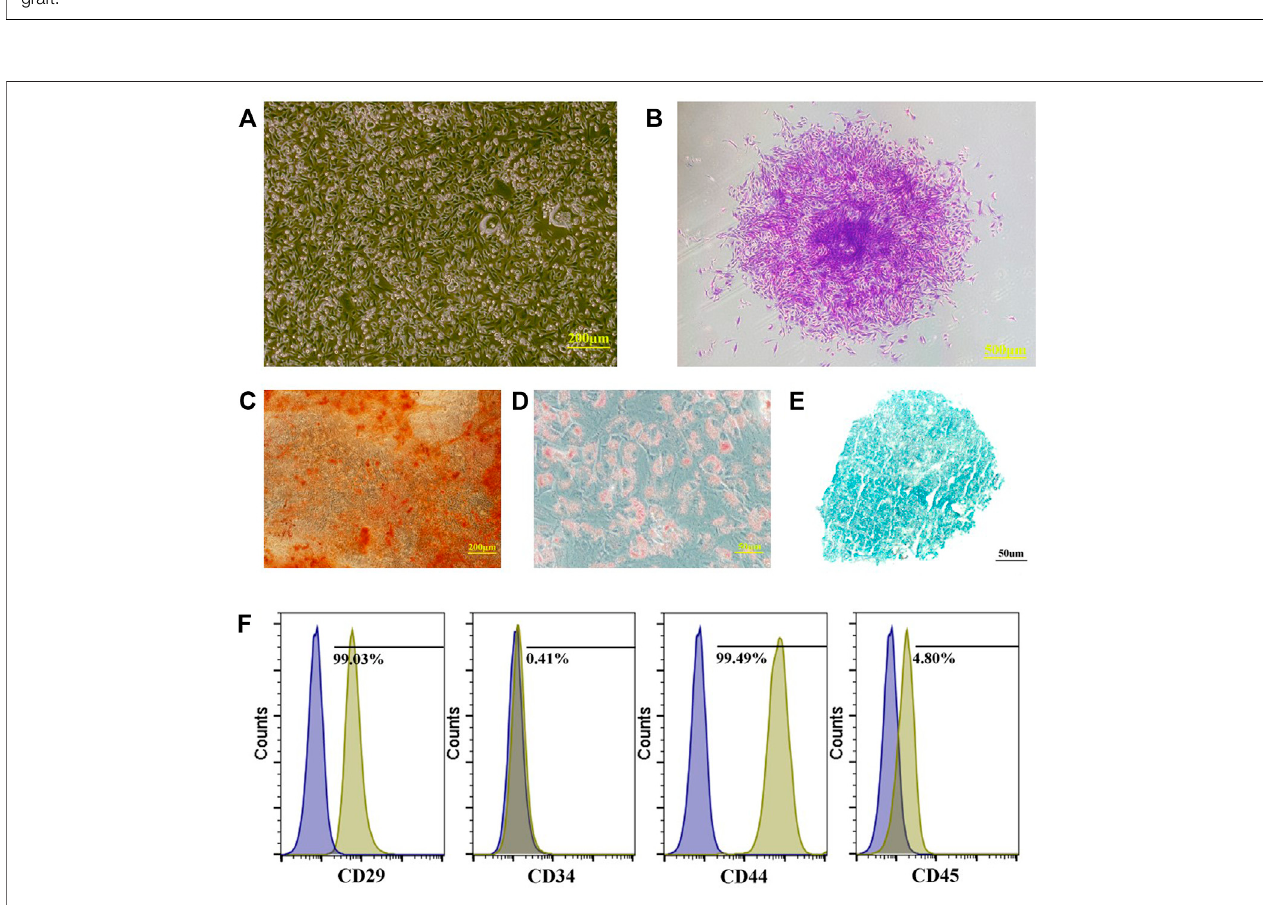
FIGURE 1 | Intraoperative pictures of meniscus graft implanted into knee joint and surgery grouping. (A) removal of meniscus; (B) graft implanted; (C) meniscus graft.